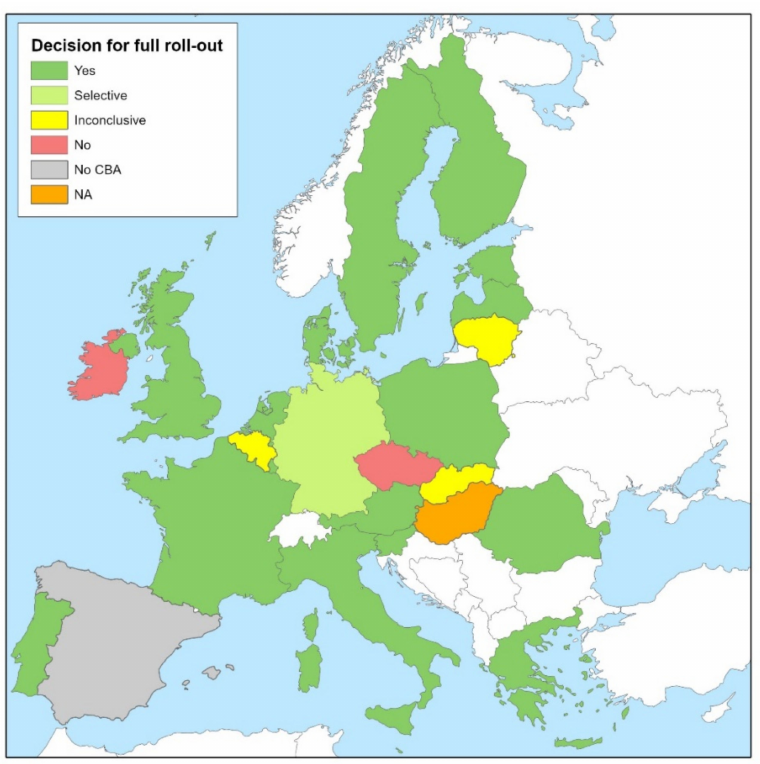
Figure 2. Information on national smart meter roll-out decision.